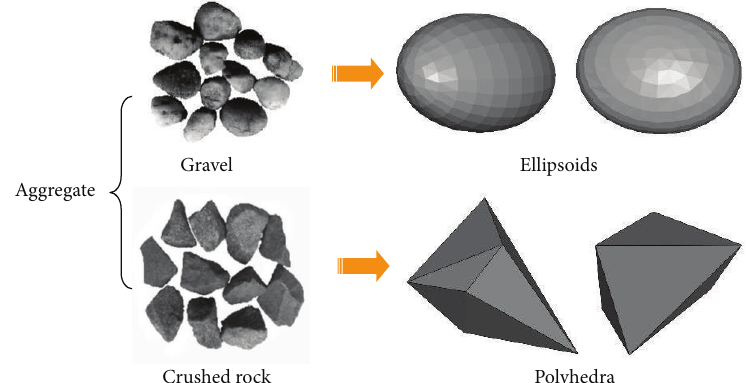
Figure 1: Simulation strategy of arbitrary shaped aggregate: (top) differently shaped ellipsoids represent river gravel; (bottom) differently shaped polyhedrons represent crushed